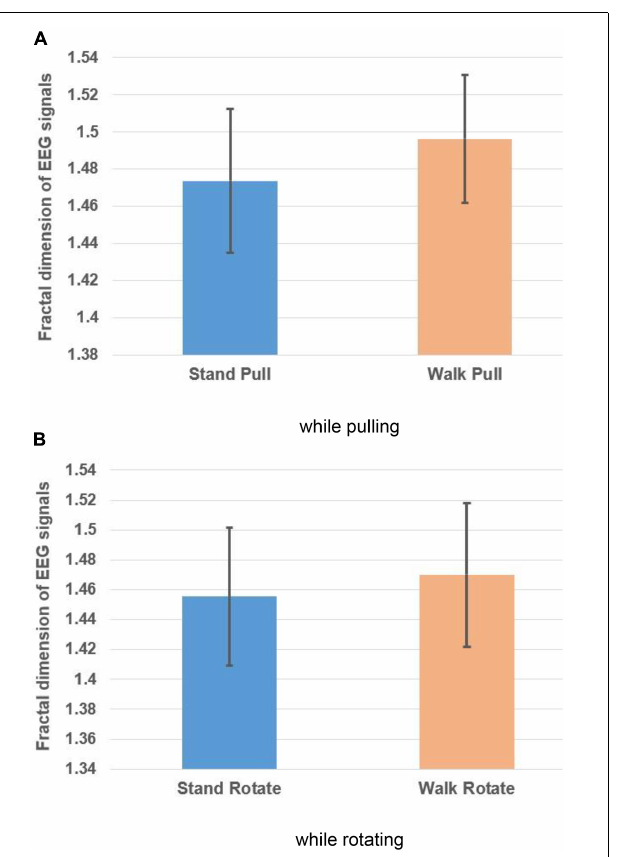
FIGURE 4 | The fractal dimension of EEG signals in walking and standing while pulling (A) and rotating (B) . Error bars indicate standard deviation.